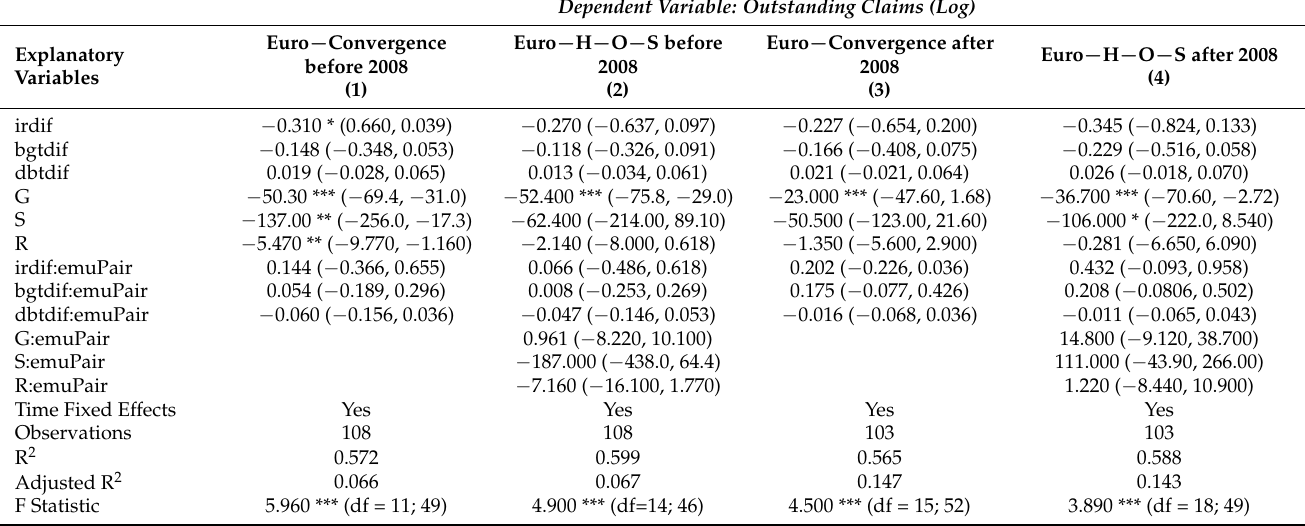
Table 4. Regression